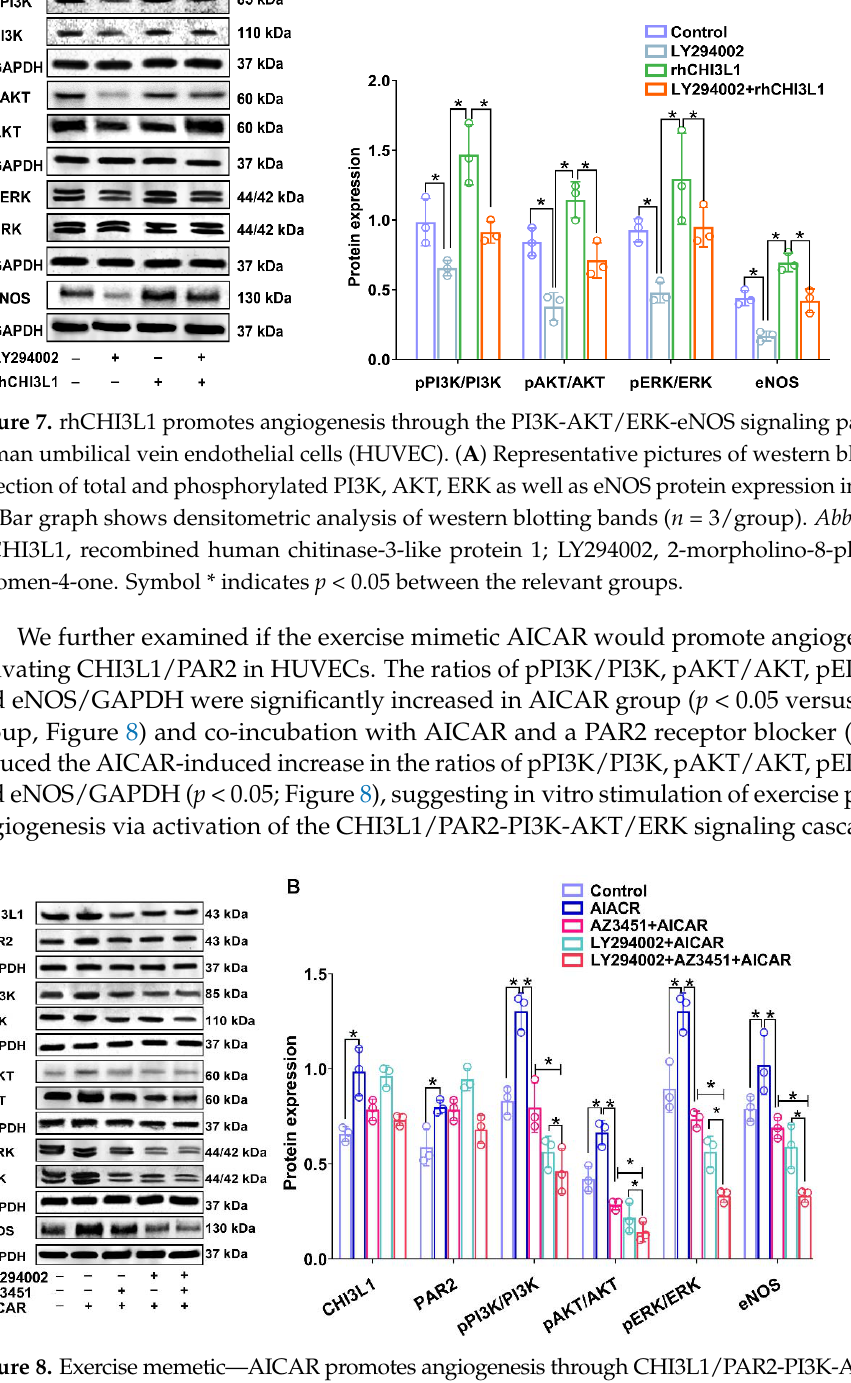
Figure 8. Exercise memetic—AICAR promotes angiogenesis through CHI3L1/PAR2-PI3K-AKT/ERK- eNOS signaling pathway in human umbilical vein endothelial cells (HUVEC). ( A ) Representative pictures of western blotting for detection of CHI3L1, PAR2, total and phosphorylated PI3K, AKT, ERK, and eNOS protein expression in HUVEC under various drug treatments. ( B ) Bar graph shows densitometric analysis of western blotting bands ( n = 3/group). Abbreviations: LY294002—2 ‐ morpholino ‐ 8 ‐ phenyl ‐ 4H ‐ chromen ‐ 4 ‐ one; AICAR—5 ‐ aminoimidazole ‐ 4 ‐ carbox ‐ amide ‐ 1 ‐β‐ D ‐ ribofuranoside; Symbol * indicates p < 0.05 and ** indicates p < 0.01 between the rele ‐ vant groups that are compared. 4. Discussion Adequate exercise training in patients recovering from MI can promote adaptive and beneficial changes in cardiac morphology and function, such as alleviated myocardial cell hypertrophy, apoptosis, and inflammation, as well as improved myocardial contractility and pumping function [27,28]. Despite the traditional caution on the risk of exercise ‐ in ‐ duced adverse events in patients with acute MI, recent studies have increasingly sug ‐ gested that a lack of physical activity after MI would have little benefits in cardiac func ‐ tion, rather have negative effects on skeletal muscle, such as causing muscle atrophy [29]. The most salient result of our present study is the fact that four weeks of aerobic exercise after MI significantly increased protein expression and mRNA levels of CHI3L1 and its receptor PAR2 in the border zone of MI (Figure 4) and significantly improved post ‐ MI ventricular function and reduced myocardial fibrosis (Figure 2). Post ‐ MI exercise training also elevated serum levels of CHI3L1 (Figure 5), which are most likely originated from exercising skeletal muscles. Additionally, our results confirmed that the previously reports showing that exercise training promoted capillary growth and angiogenesis in the heart [30–32]. Although the mechanism of exercise ‐ induced angiogenesis is not fully understood, the beneficial effects seem to be closely related to changes in hemodynamics, such as increase in blood flow and/or venous return, as well as upregulation of genes and proteins that are responsible for angiogenesis in vascular endothelial cells. Elevated blood flow changes and shear stress on the vessel wall after exercise can activate PI3K ‐ AKT ‐ eNOS and improve endo ‐ thelial function [33]. Exercise training can also promote cardiovascular angiogenesis [34– 36]. Myocardial inflammation and oxidative stress are activated after MI, which result in cardiac cell necrosis and apoptosis and, in turn, lead to ventricular contractile dysfunction. Improving angiogenesis in patients with MI is one of the important ways to alleviate MI ‐ induced cardiac injury and dysfunction and to promote post ‐ MI rehabilitation of the in ‐ jured heart [37]. The present study confirmed that post ‐ MI exercise training significantly reduced cardiac cell apoptosis and increased angiogenesis in the rat hearts. We also